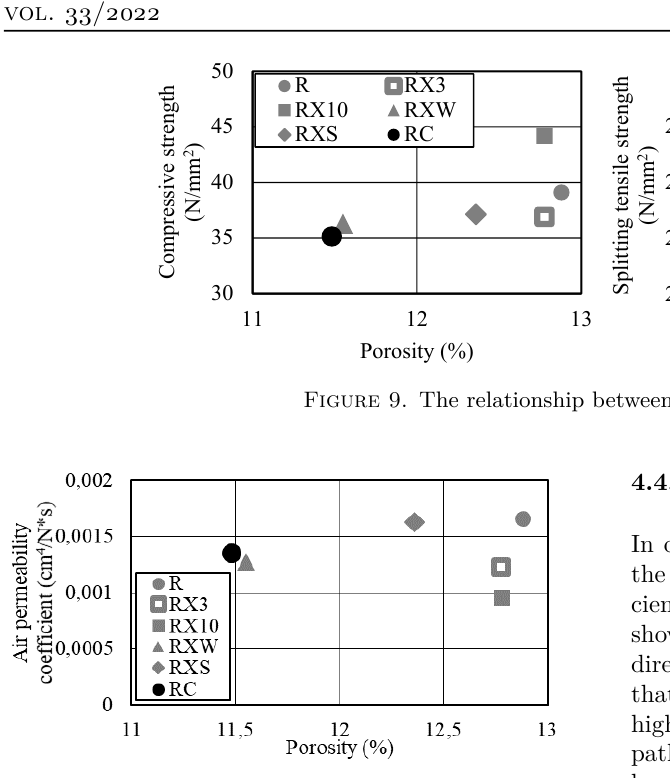
Figure 10. The relationship between porosity and air